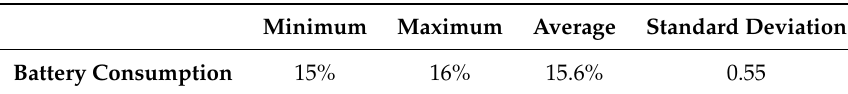
Table 7. Battery